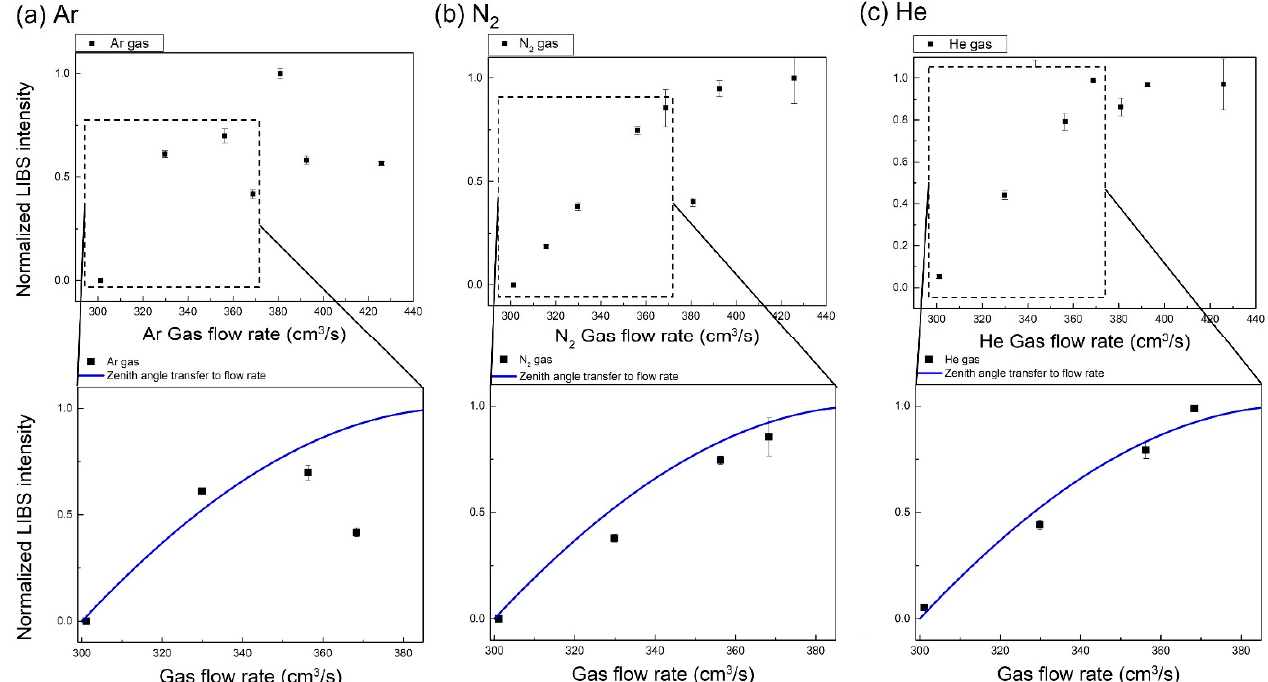
Figure 13. LIBS spectral line intensity according to the flow rate and trends in signal intensity obtained through modeling; ( a ) Ar, ( b ) N 2 , and ( c ) He gas.